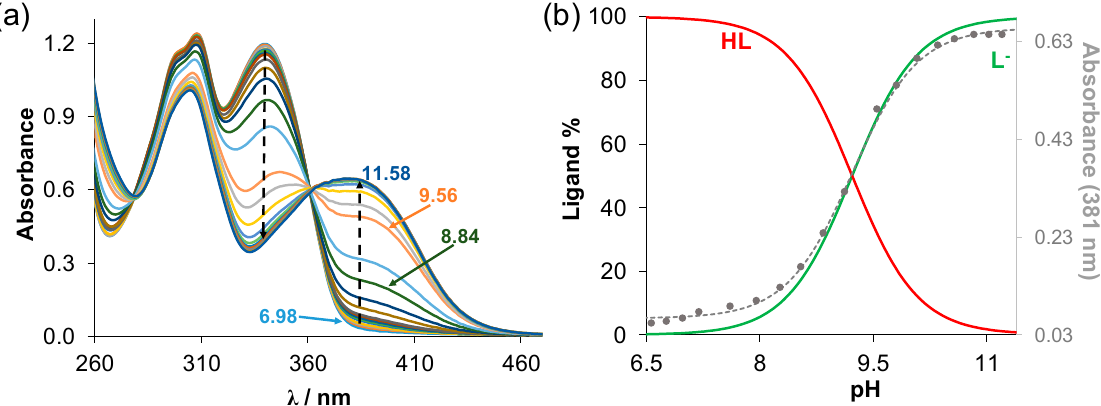
Figure 1. ( a ) UV–vis absorption spectra of estradiol-TSC recorded at various pH values in 30% ( v/v ) DMSO/H 2 O solvent mixture (c ligand = 20 μ M; T = 25.0 °C; I = 0.1 M (KCl); ℓ = 2 cm); ( b ) concentration distribution curves for this ligand with absorbance values measured at 381 nm ( • ) with the fitted curve. HL denotes the neutral form of the compound.